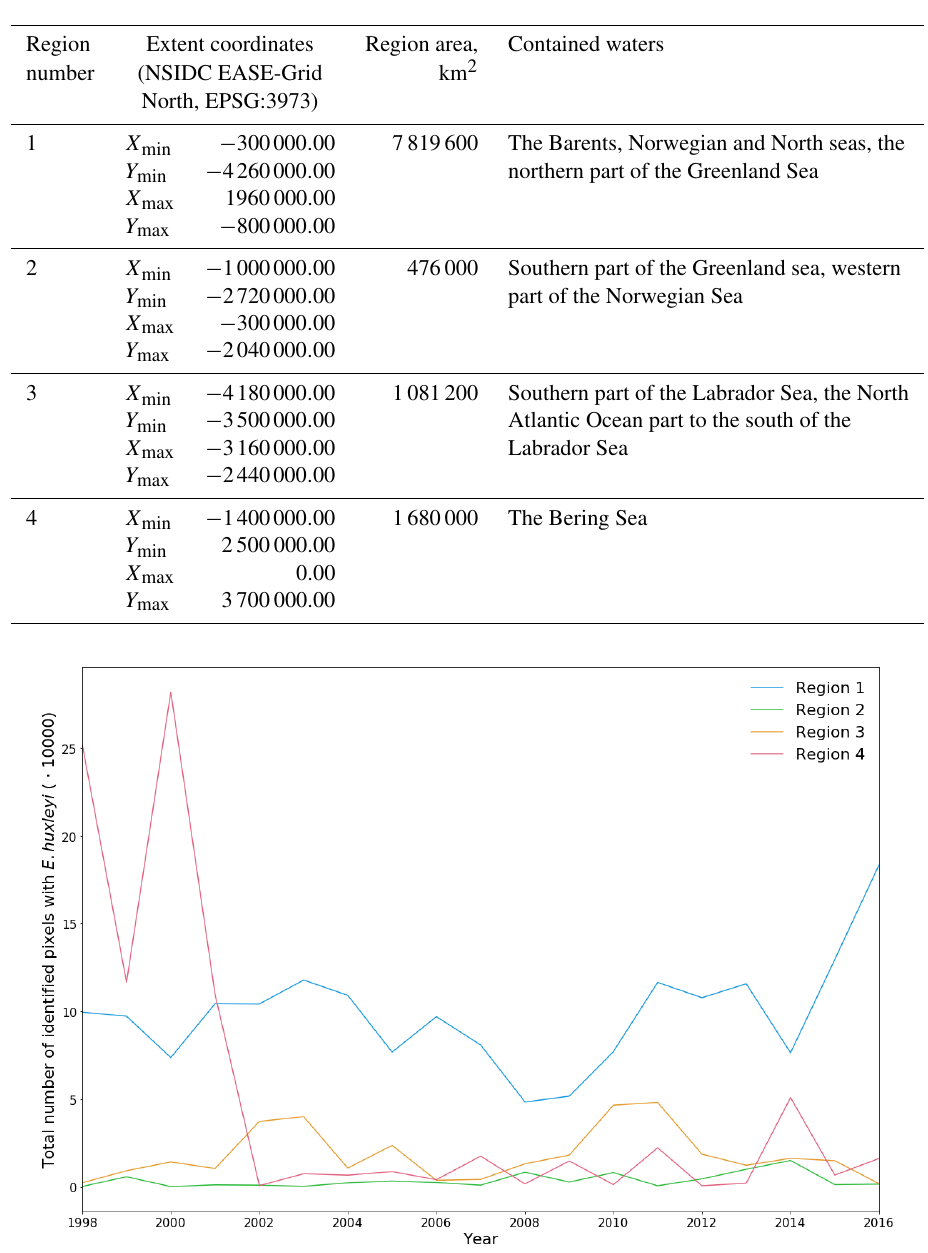
Figure 4. Total number of identified pixels with Emiliania huxleyi for each blooming season in the period 1998–2016 within the four regions specified in Fig.